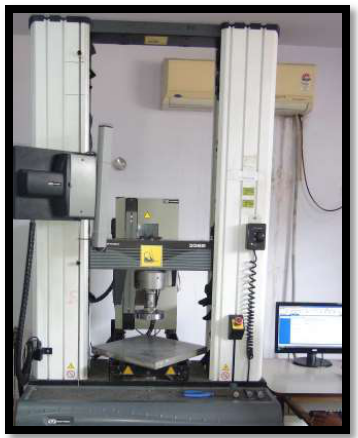
Figure 5. INSTRON 3382 series operating on Bluehill software Universal Testing Machine.